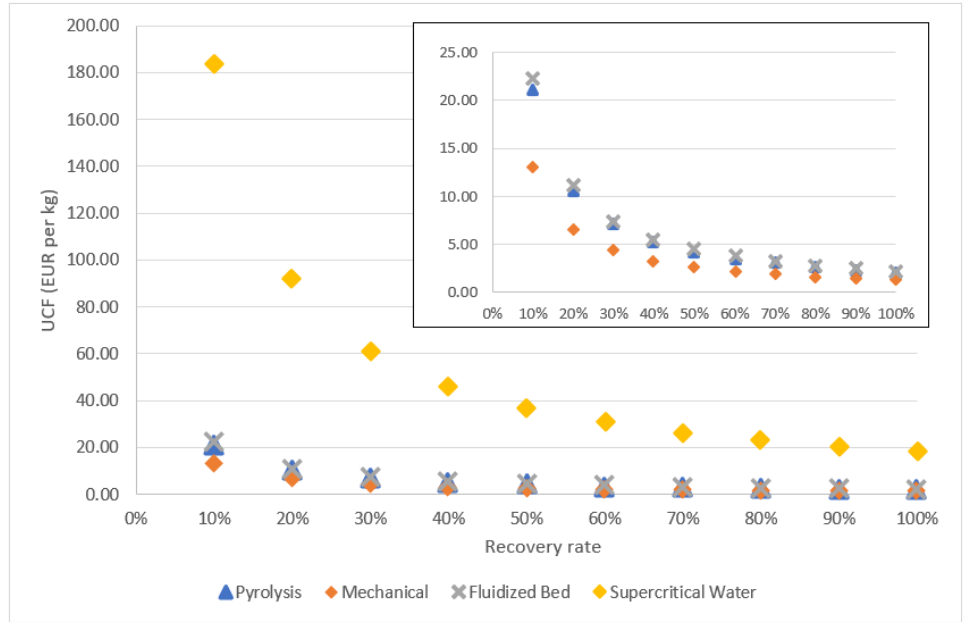
Figure 7. Unit cost per mass of recovered carbon fiber at 2000 tons/year and at different recovery rates.